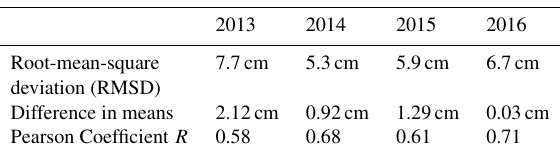
grid cell. The DuST retrieved for each point is plotted against OIB snow depth.